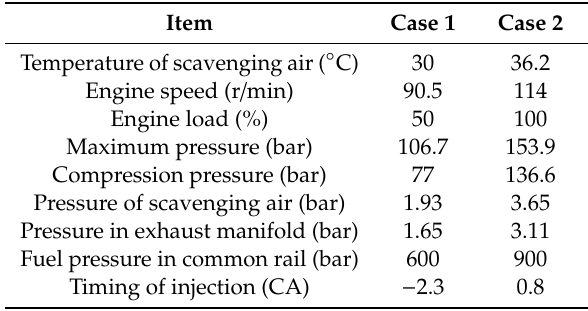
Table 2. Parameters of the two cases of the engine running